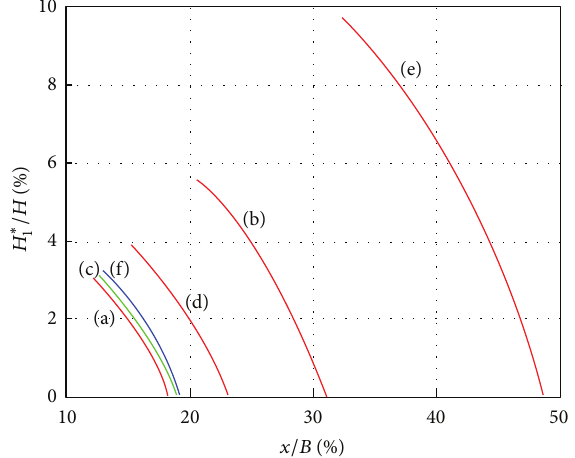
Figure 9: Variation of the dimensions of the plastic zone for the unstrengthened panels.